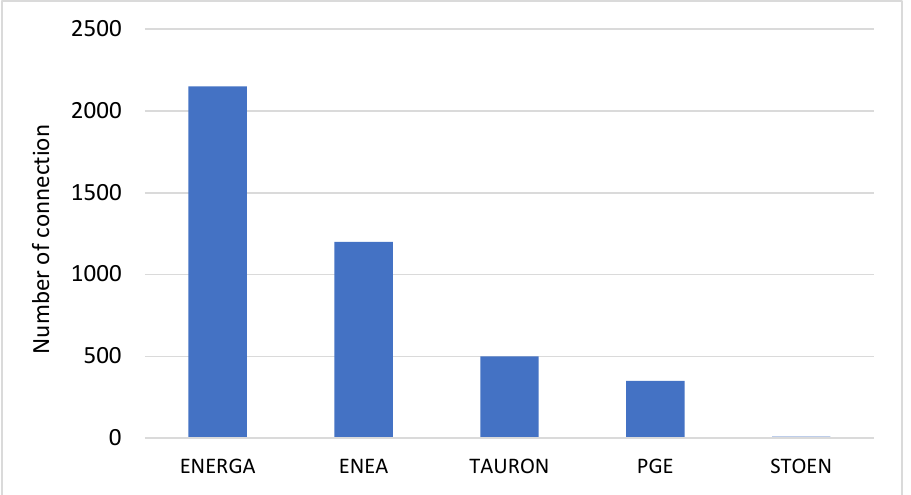
Figure 6. Number of connection applications rejected by Polish distribution system operators between 2017 and 2021.